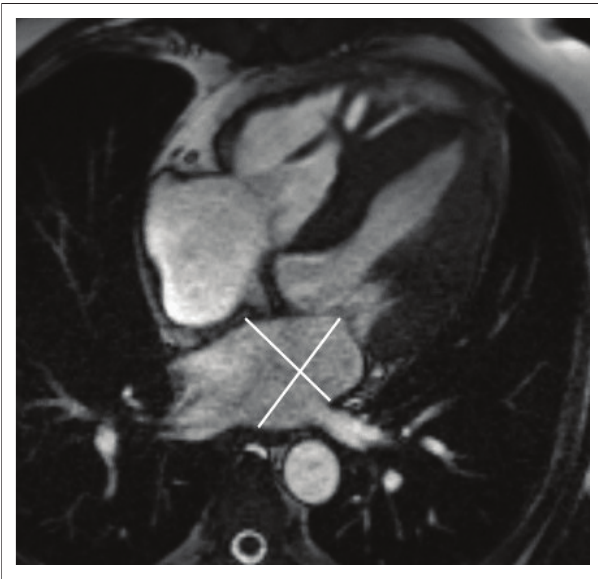
FIGURE 10: Four-chamber cine SSFP image of the heart. The atria can also be measured with the biplanar method with a longitudinal measurement from the mid atrioventricular valve to the posterior atrial wall and a perpendicular measurement transversely through the mid atrium.